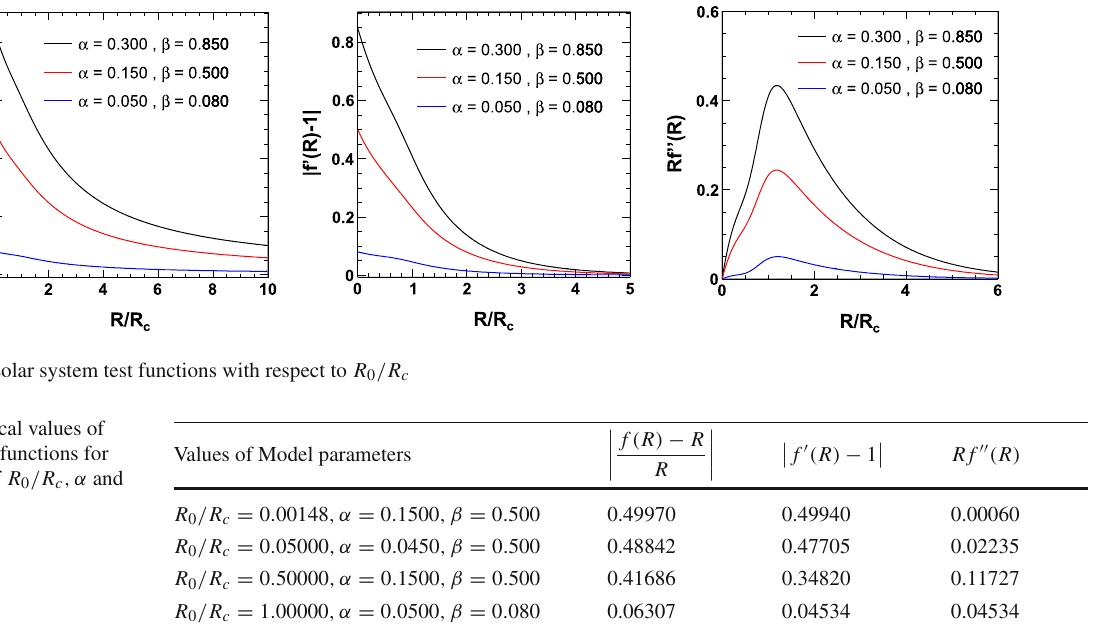
Values of Model parameters